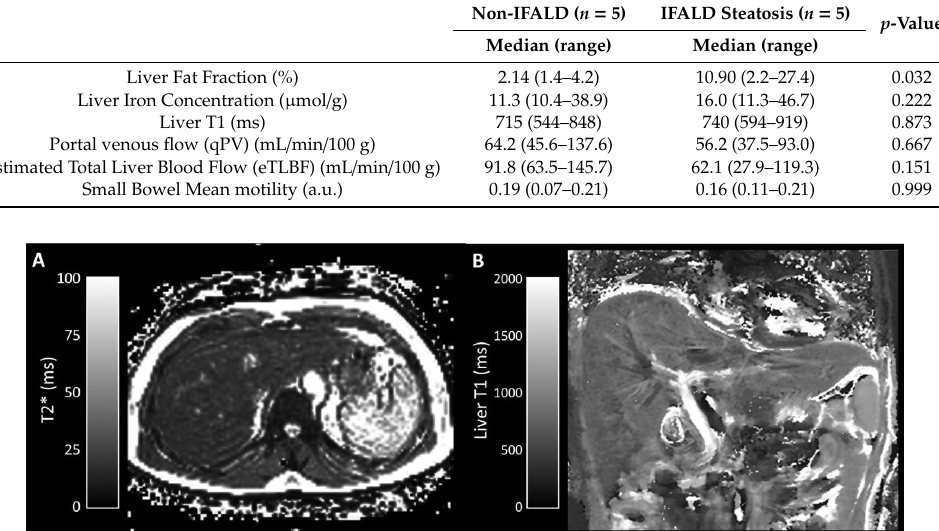
Figure 3. Axial MRI Proton Density Fat Fraction map examples from ( A ) non-IFALD and ( B ) IFALD steatosis patients. Average liver fat fraction was ( A ) 1.4% for the non-IFALD patient as represented by the darker liver parenchyma and ( B ) 27.4% for the IFALD steatosis patient as represented by the brighter liver parenchyma. Note the striking disparity in subcutaneous adiposity between patients. Table 6. Comparison of MRI imaging Scores against described normal values.